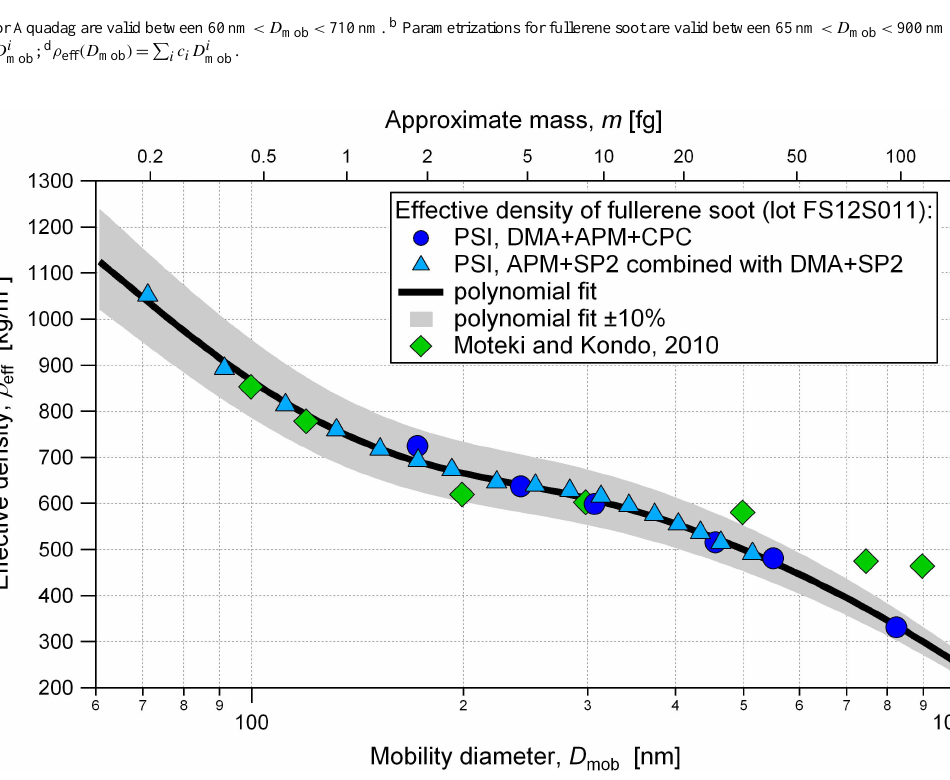
Fig. 4. Effective density of fullerene soot as a function of mobility diameter. The approximate mass scale given at the top axis has been calculated from the mobility diameters of the bottom axis using the polynomial